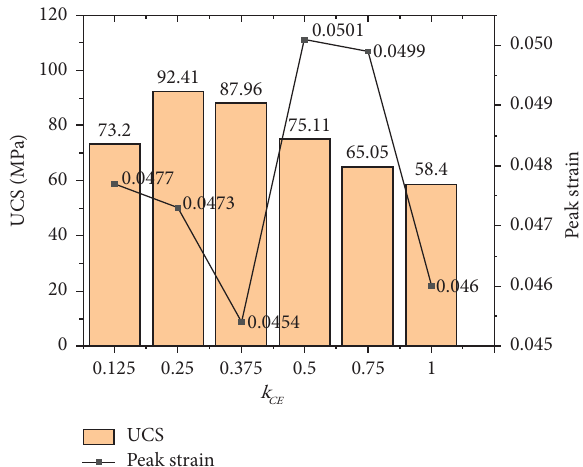
Figure 15: UCS and peak strain for diferent k